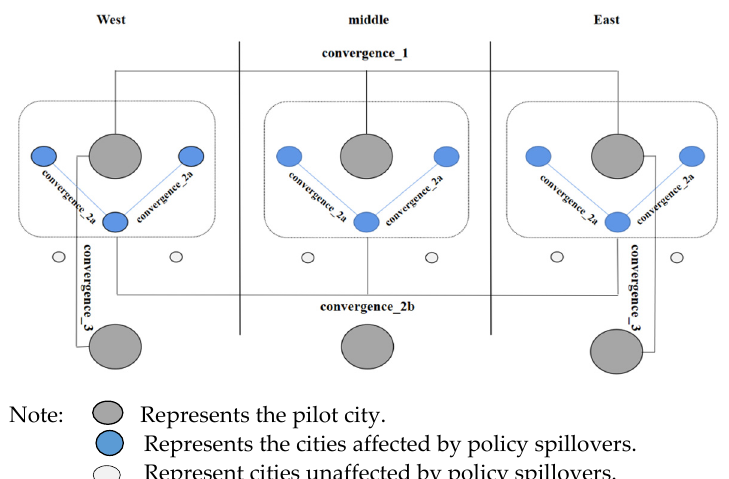
Figure 2. Types of convergence and research